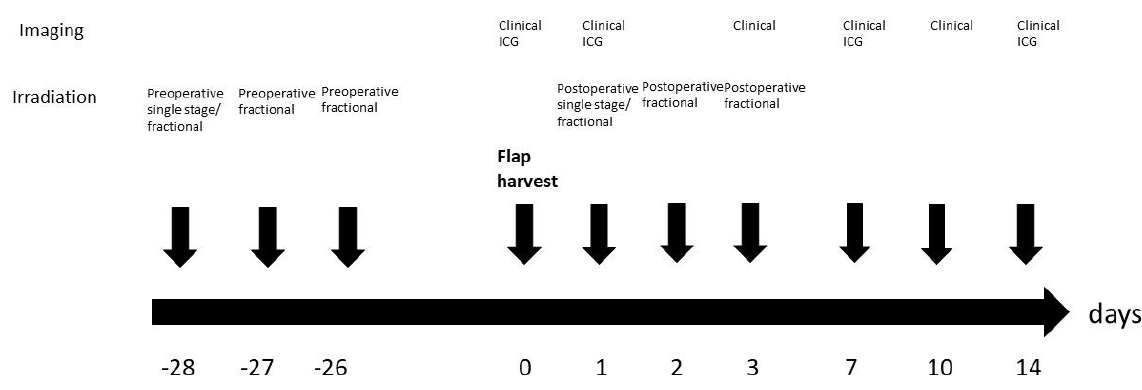
Figure 2. Irradiation procedure: ( A ) rat positioned for irradiation; ( B ) irradiated area.